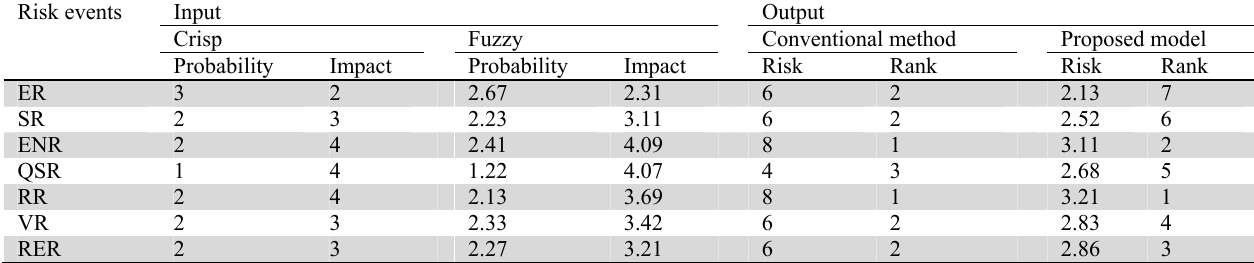
The comparison of risk assessment